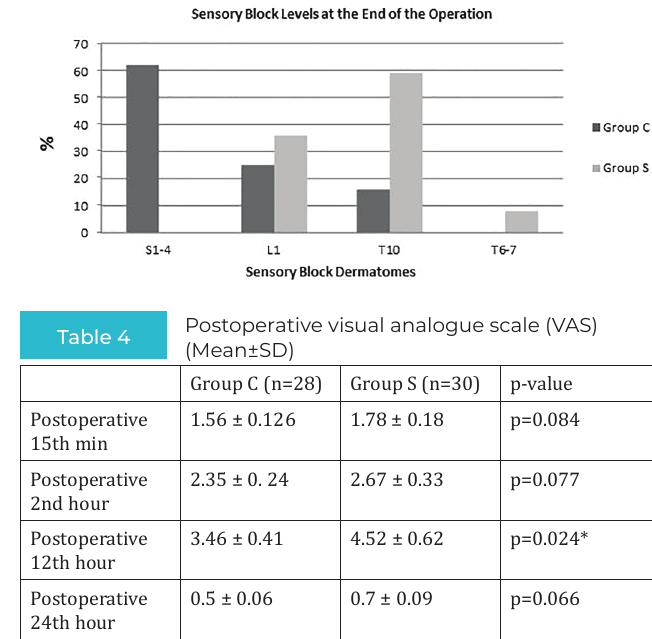
Figure 1 - Comparison of the groups with respect to the level of sensory block